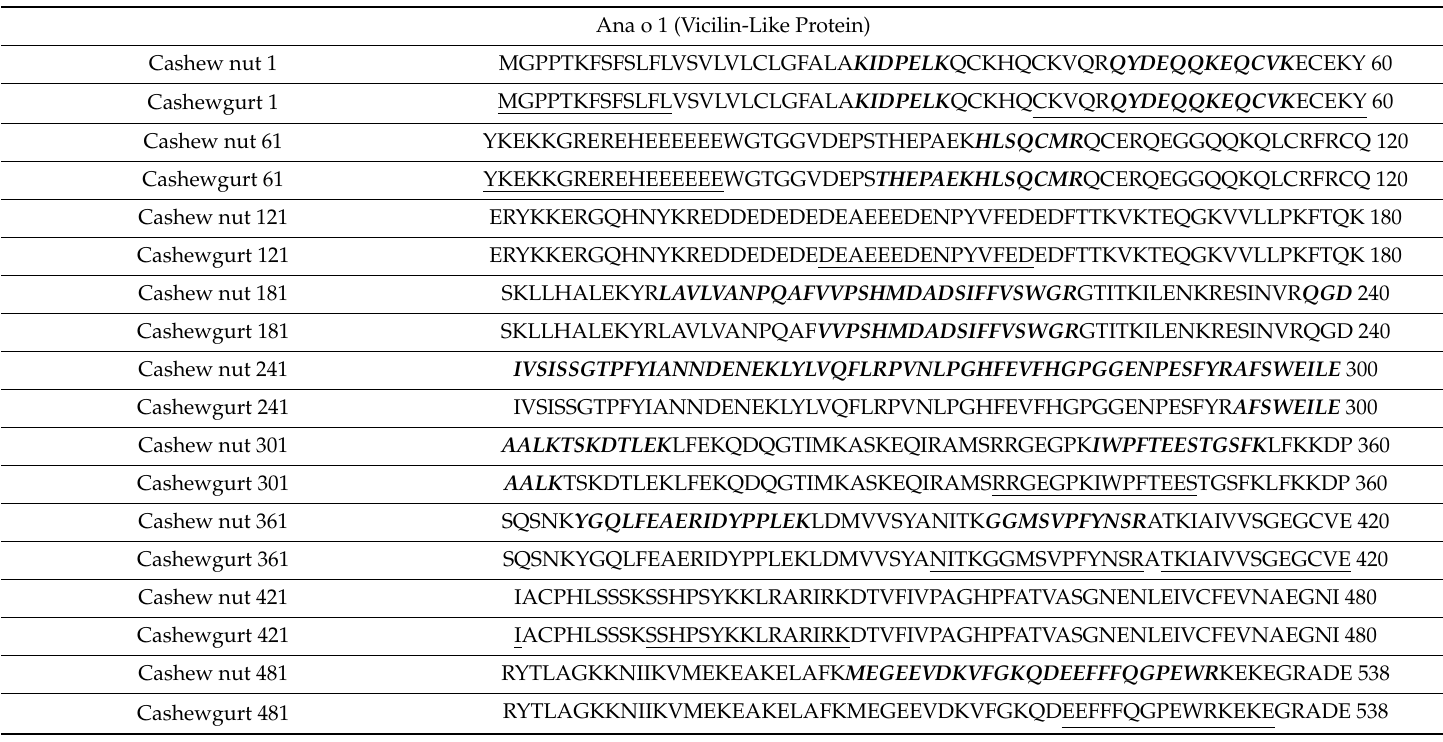
Table 2. Ana o 1, Ana o 2, and Ana o 3 peptides observed by LC–MS / MS in soluble Cashewgurt